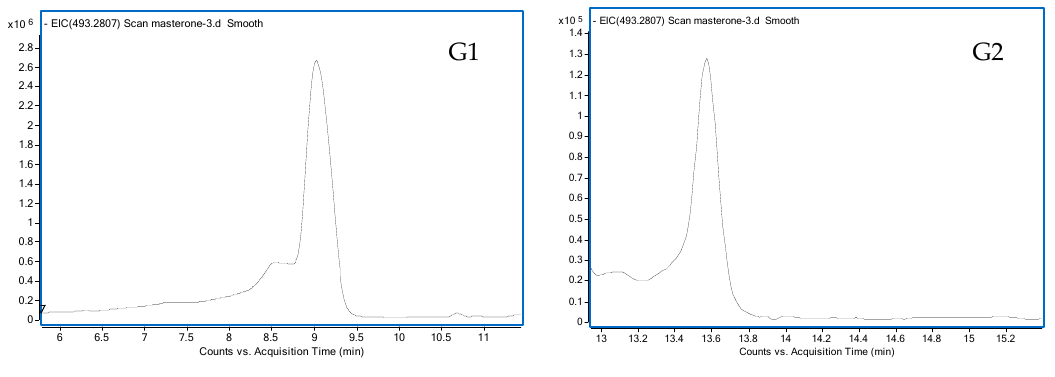
Figure 1. The chemical structures of methasterone and its intact metabolites (G2, G6, G7, S1, S2, M2, M4 and M6 were unreported metabolites, and G4, G5 and M5 were obtained for the first time in human urine).